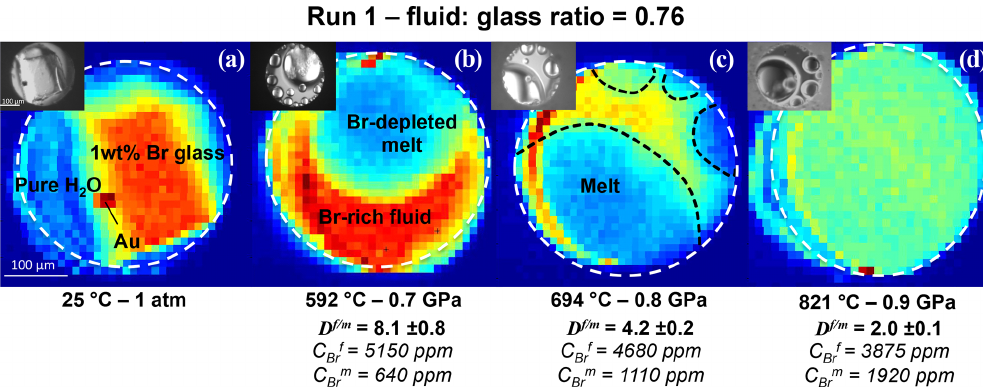
Figure 2. 2D SXRF Br K α intensity maps of Run 1 showing the distribution of Br between coexisting aqueous fluid and haplogranite melt at different P – T conditions. The fluid:glass ratio refers to the weight fraction calculated from the volumetric proportions of loaded glass and the sample chamber. The white dashed line delimits the edge of the Re gasket. Br-enriched phases appear in red and yellow, Br-depleted areas in blue and green. At the beginning of the experiment (a) , all the Br is concentrated in the glass. After the glass melts (b) , Br strongly = 8 . 07 ± 0 . 79). As temperature increases, the Br concentration in the melt increases, while the Br partitions into the fluid phase ( D f / m Br concentrations in the fluid decreases (c) . At 821 ◦ C and 0.9GPa, the I f / m ratio appears homogeneous as the Br concentrations per volume = 2 . 02 ± 0 . are almost similar ( I f / m = 1 . 3 ± 0 . 1). However, per weight, Br still partitions preferentially into the fluid ( D f / m Br